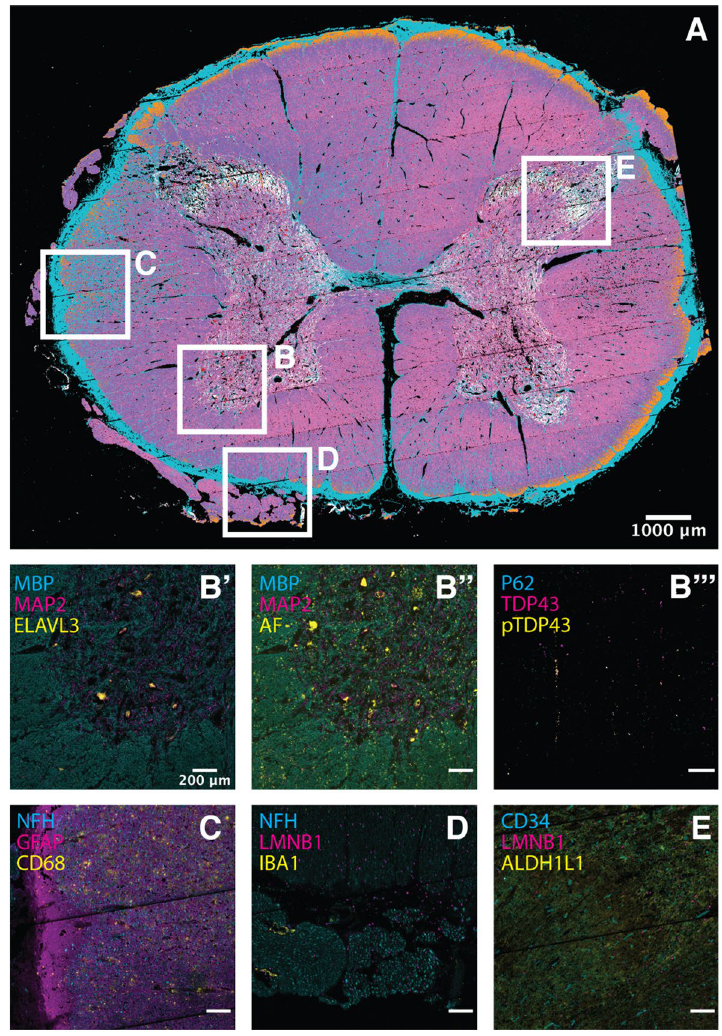
Figure 4. High-plex 4i tissue profiling of human postmortem spinal cord. Fresh frozen tissue sections from ALS patient spinal cords were subjected to 14-plex profiling over six 4i cycles. ( A ) K-means clustering of 4i data was used to visualize tissue domains defined by all 14 channels across the entire tissue section. Each of 7 clusters is assigned a unique color and inset locations are noted ( B – E ). ( B ′ ) Higher magnification image of anterior horn inset region ( B ). Cell type marker MBP (cyan) is expressed by oligodendrocytes, MAP2 (magenta) is expressed in neurons and neuronal processes, and ELAVL3 (yellow) is expressed by neurons, including motor neurons. ( B ″ ) Same as ( B ′ ), but yellow is used to visualize tissue autofluorescence. ( B ′″ ) Pathological markers P62 (cyan), TDP-43 (magenta), and hyperphosphorylated TDP43 (yellow) are visualized in the same FOV as in ( B ′ , B ″ ). ( C ) Higher magnification image of lateral white matter inset region ( C ). Cell type markers NFH expressed in neurons (cyan), GFAP expressed in astrocytes (magenta), and CD68 expressed in activated microglia (yellow) are visualized. ( D ) Higher magnification image of ventral white matter inset region ( D ). Cell type markers NFH expressed in neurons (cyan), IBA1 expressed in microglia (yellow), and nuclear envelope marker LMNB1 (magenta), are visualized. ( E ) Higher magnification image of dorsal horn inset region ( E ). Cell type markers CD34 expressed in endothelial cells (cyan), ALDH1L1 expressed in astrocytes (yellow), and nuclear envelope marker LMNB1 (magenta), are